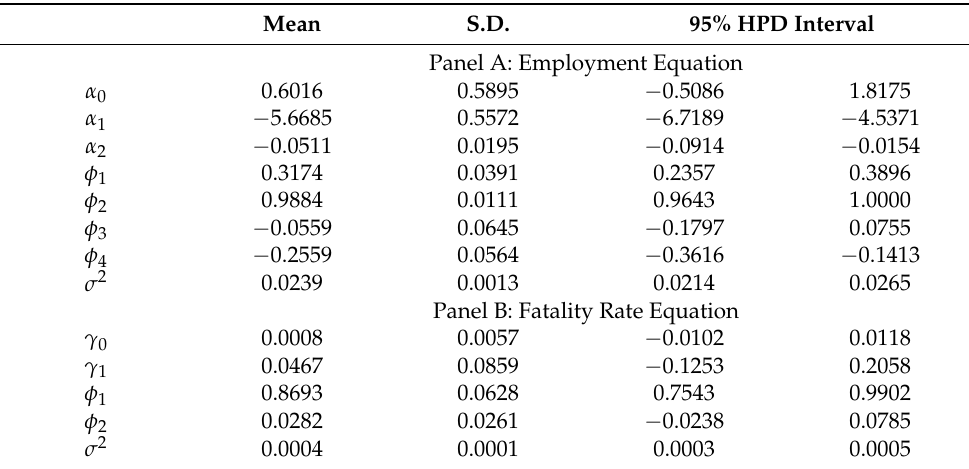
Table 2. Summary statistics for the posterior distributions of the parameters from the Florida employment and fatality rate models. Mean S.D. 95% HPD